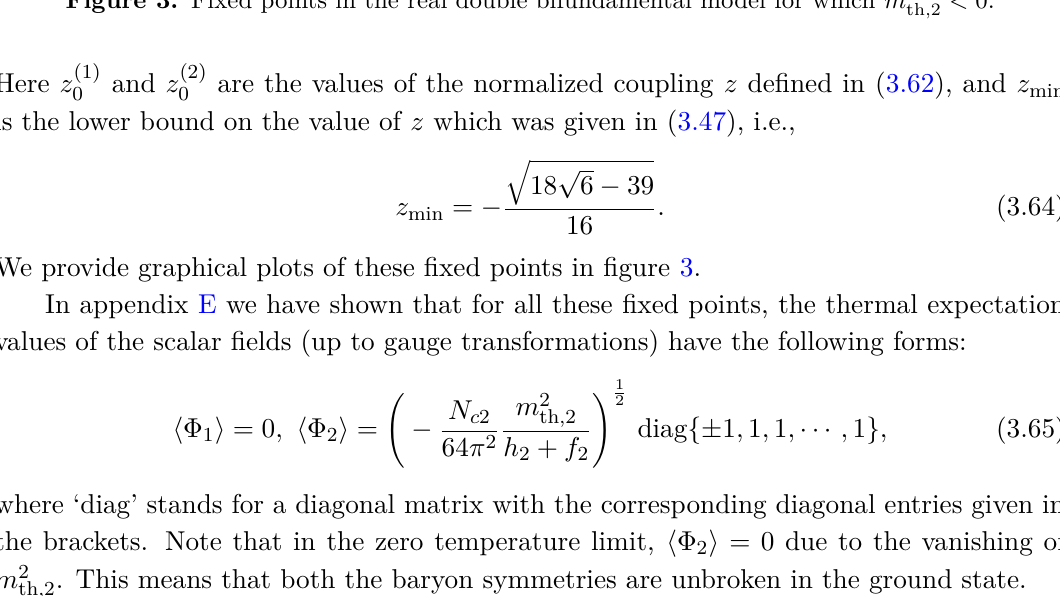
Figure 3. Fixed points in the real double bifundamental model for which m 2